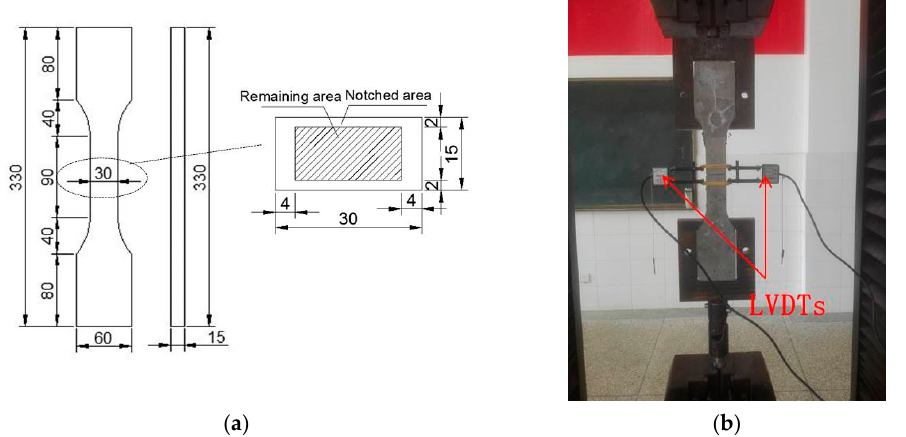
Figure 6. Single-crack tensile test. ( a ) Diagram of specimen size (Unit: mm); ( b ) photo of the test device.